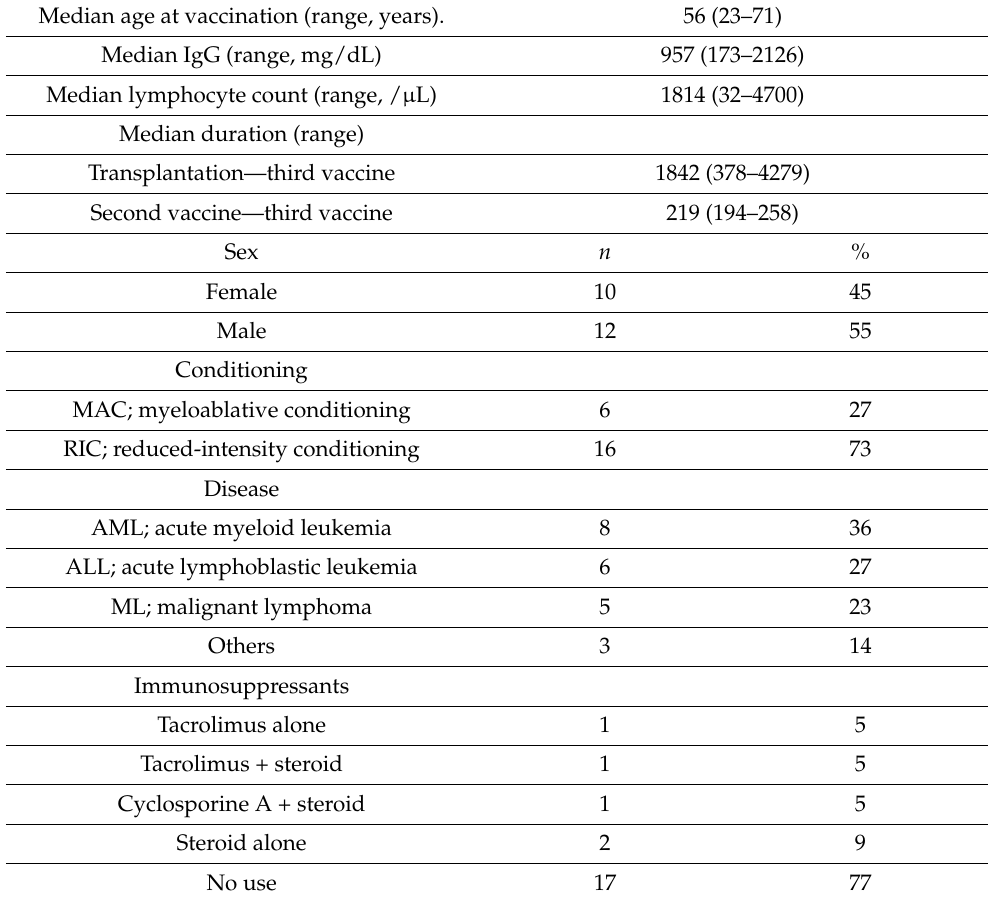
Table 1. Patient characteristics at the third vaccination. Median age at vaccination (range,